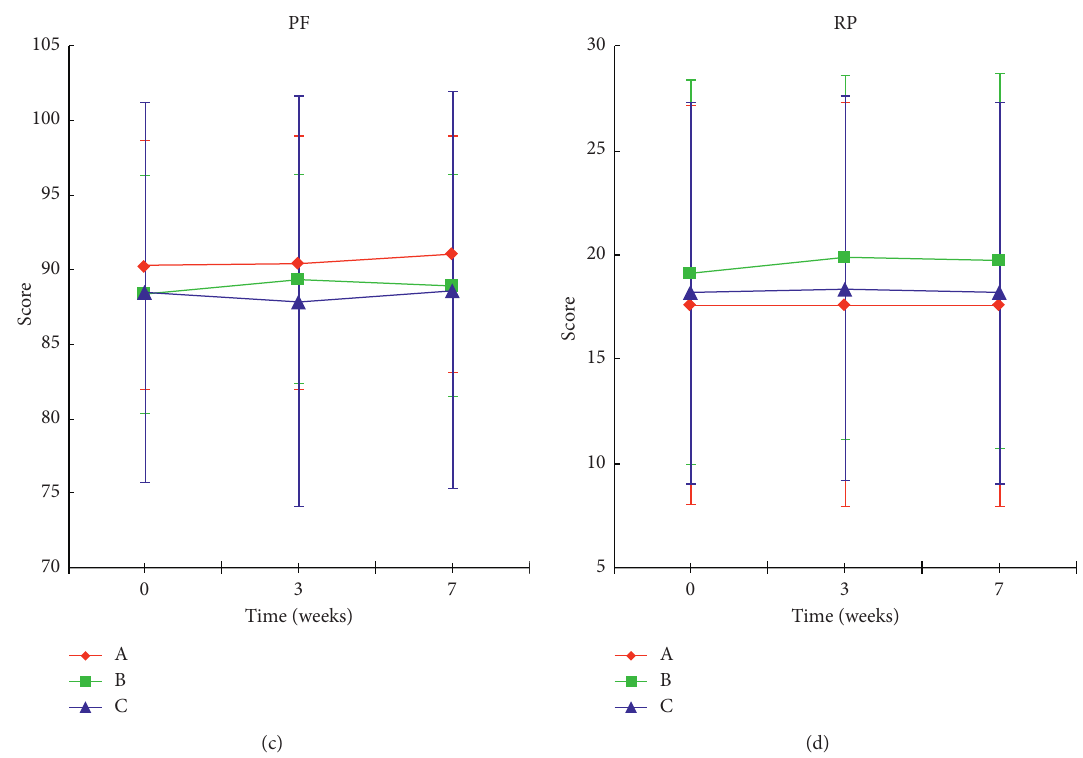
Figure 6: Comparison of the scores of the four health survey dimensions of each group of patients. The data were expressed as mean ± s ( n �